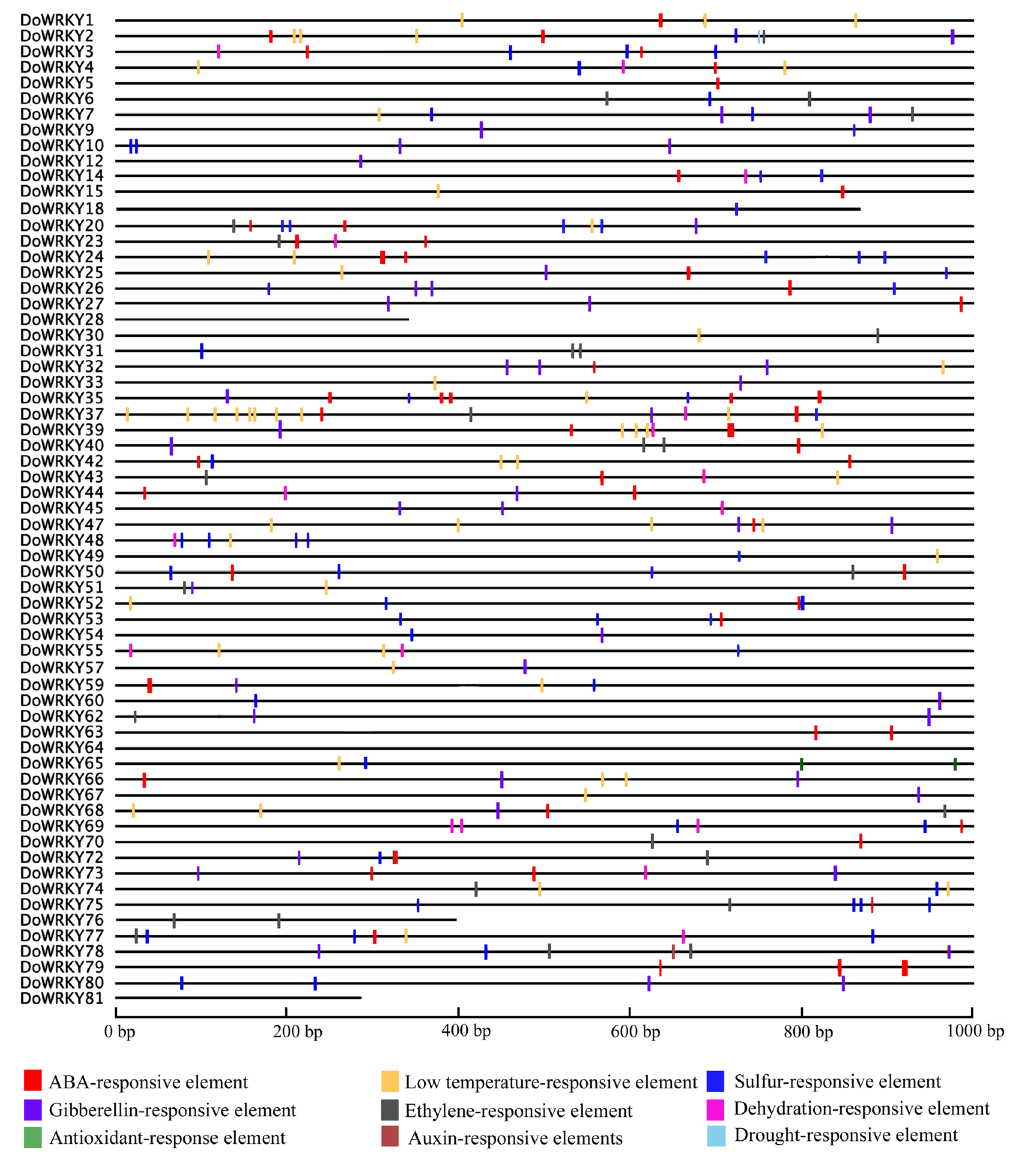
Figure 4. Prediction of cis -responsive elements in the 1-k upstream regulatory regions of DoWRKY genes. Different cis -responsive elements are represented by different colored